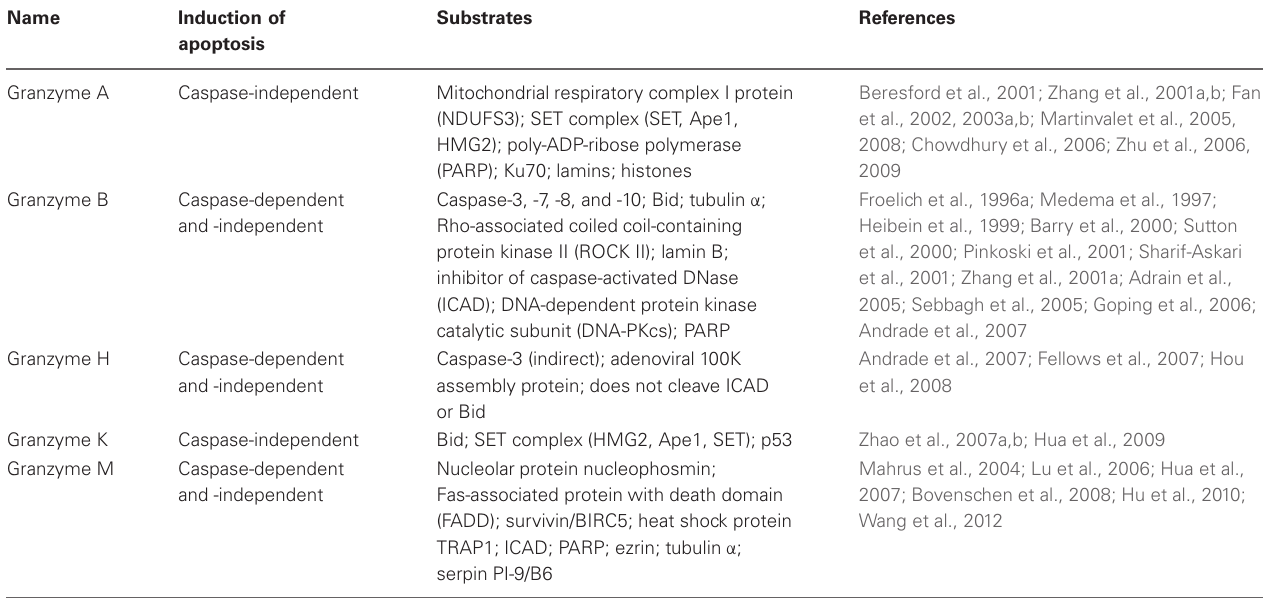
Table 2 | Granzymes and their